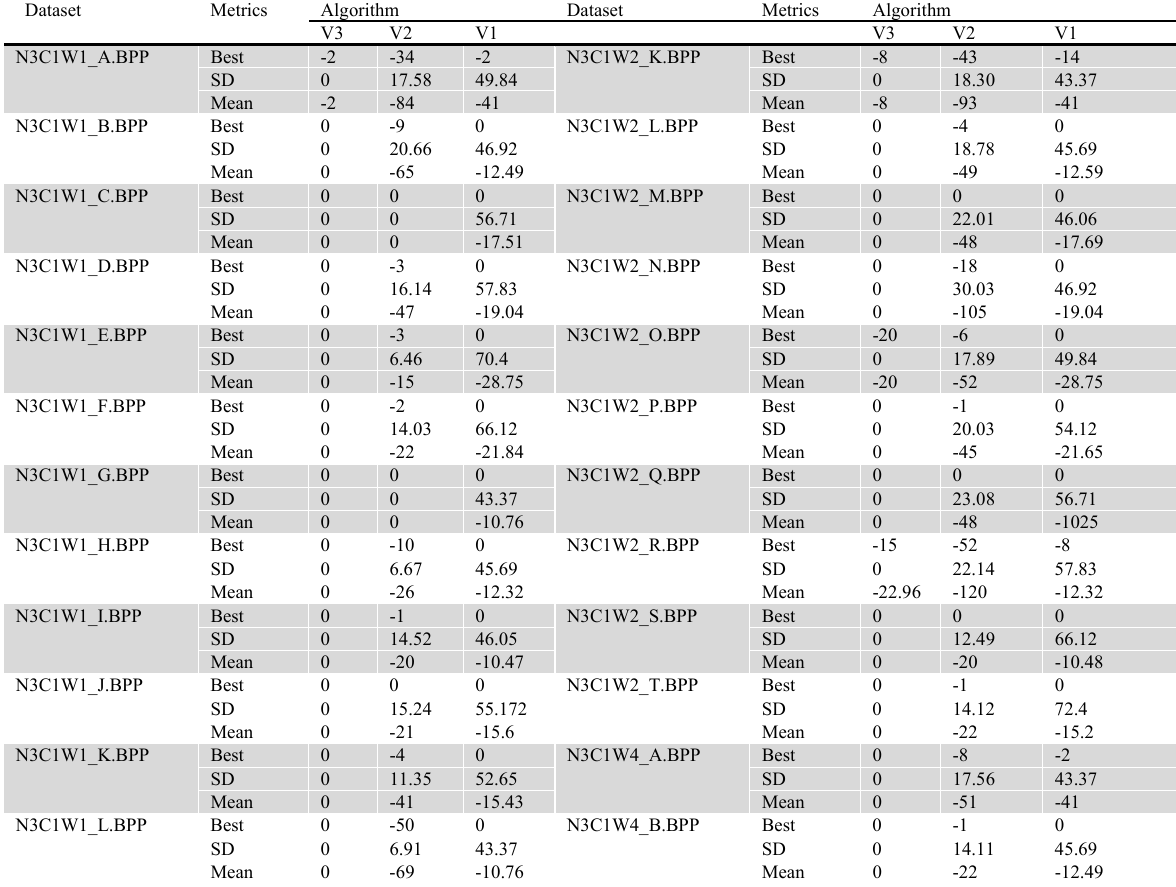
Table 2 and 3 show the performance of three HS variations on 60 datasets with 200 objects and 60 datasets with 500 objects respectively. For evaluation, metrics such as best, mean and standard deviation are used. The negative objective values of best and mean indicates the penalties applied for constraint violations. The proposed harmony search algorithm (V3) outperforms the other two variations for all the instances. Whereas the performance of version 1 and version 2 are approximately the same. Table 2 Best, mean and standard deviation values for proposed HS variations for 60 datasets with 200 objects